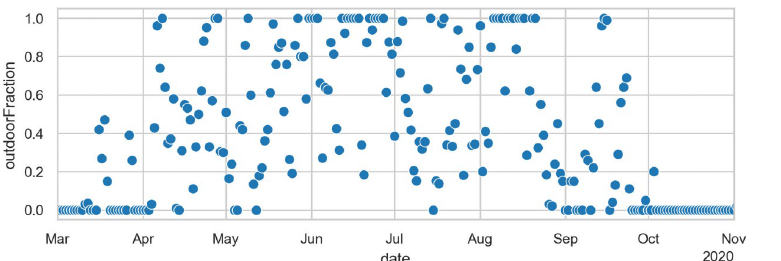
Fig 9. Outdoors fraction for activities of type leisure, depending on the temperature of each day.